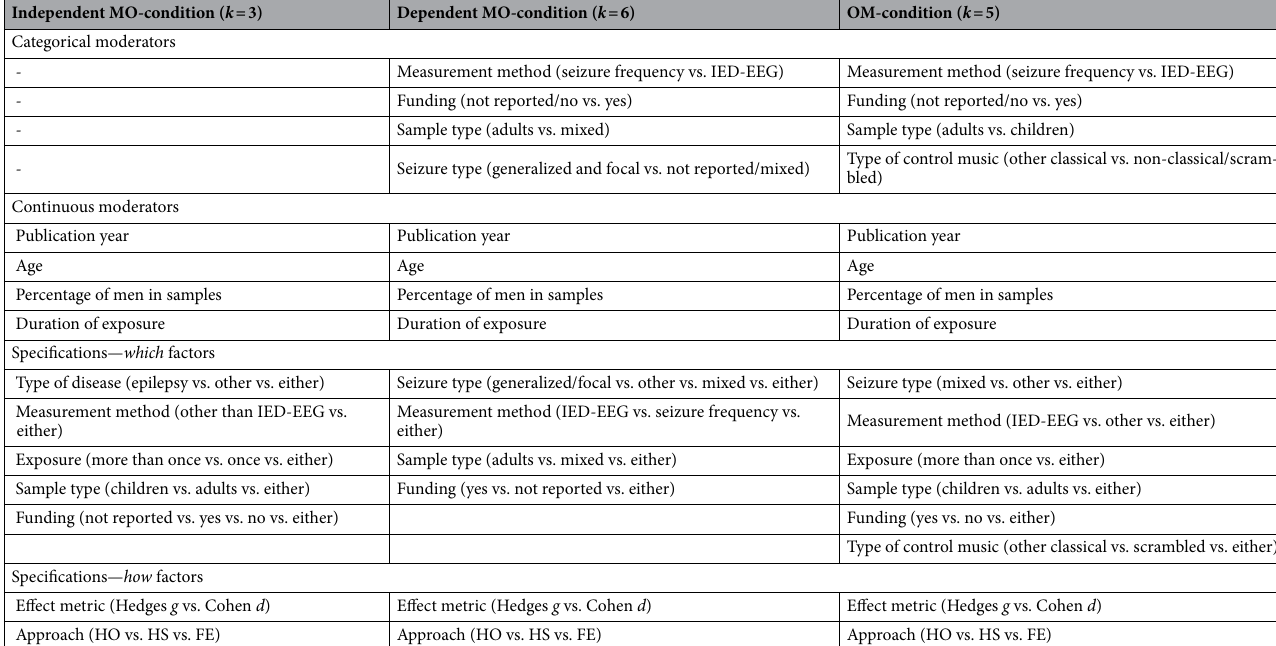
Table 1. Moderator and specification-relevant variables for three independent meta-analyses. Independent MO = independent-groups pretest–posttest designs examining KV448 versus silence 11,27,28 ;